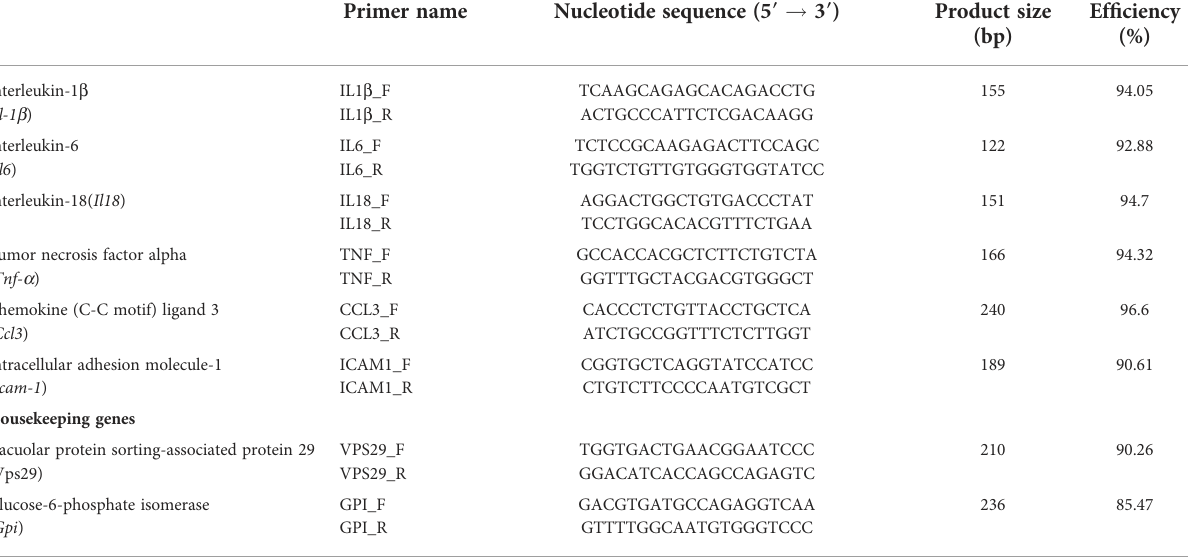
TABLE 1 Immunity-related genes with designated primer sets used to evaluate the response in Anisakis -sensitised rats measured by